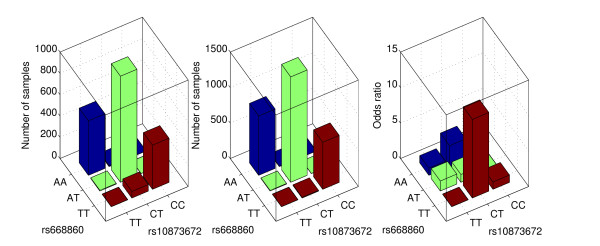
Distributions of genotypes of rs668860 and rs10873672 in the bipolar disorder data set and the odds ratio computed for combined genotypes of these two SNPs. Left Panel: The distribution of genotypes of rs668860 and rs10873672 in case samples. Middle Panel: The distribution of genotypes of rs668860 and rs10873672 in control samples. Right panel: The estimated odds ratio for the combination of rs668860 and rs10873672. The odds ratio of genotype combination "AA/TT" is used as reference. The genotype combination "TT/CT" has significantly higher odds ratio than other genotype combinations.